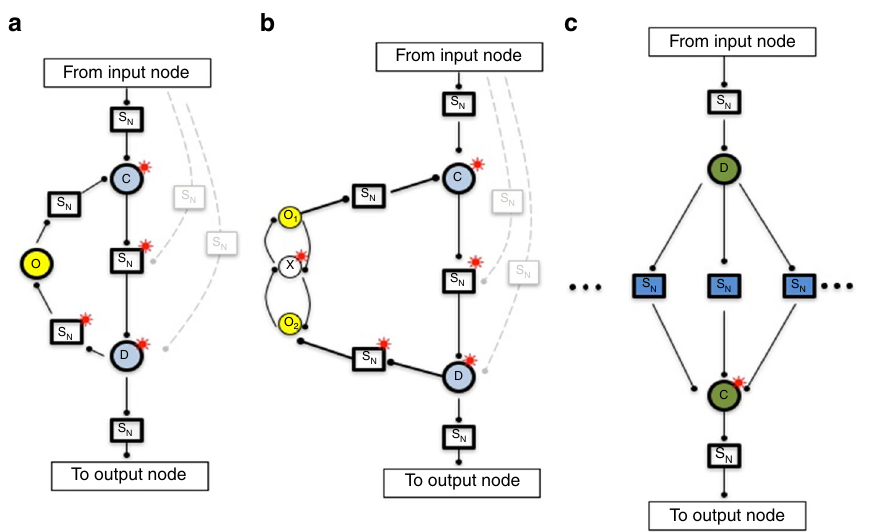
Fig. 1 Two module classes are a topological basis for RPA networks. The essential architecture of the two RPA basis modules: the Opposer Module ( a , b ) and the Balancer Module ( c ). All nodes that exhibit the RPA property are denoted with a superposed red asterisk. The symbol S N indicates that any motif or sub-network may be fully embedded at the indicated position. Interactions among nodes are indicated with a solid dot, to indicate that the interactions may be either activating or inhibitory in principle. All nodes depicted below may also (optionally) be regulated by extramodular nodes that exhibit the RPA property (blind regulations) due to the activity of other RPA modules in the larger network (not shown, for clarity). These modules rely on special computational nodes — opposer nodes, balancer nodes, and connector nodes — all of which use special classes of reaction kinetics to orchestrate their RPA- generating functions (see Supplementary Note 4). a An Opposer Module with a single opposer node (denoted O in yellow). Opposer Modules are characterized by a feedback architecture, de fi ned by an apex node (C) and a base node (D, both in blue). All routes that are contiguous with the route segment C — D are opposed by the opposer node — that is, all routes that feed into the module at some node between C and D, inclusive. The module could therefore include any of optional regulations indicated in feint. b An Opposer Module with a two-node opposing set. Structure of the module is as for part (a) except that two opposer nodes now work together in concert within a pair of interlinked circuits embedded into the feedback architecture. Opposer nodes are part of a master set, which in this case comprises {O1, X, O2}. c A Balancer Module is characterized by a collection of (at least two) parallel route segments, which diverge upstream at D and reconnect downstream at the connector node, C, both indicated in green. All nodes embedded into those route segments are balancer nodes, indicated in blue. The three dots on either side of the interior S N elements indicate that the module may contain any arbitrary number of route segments between D and